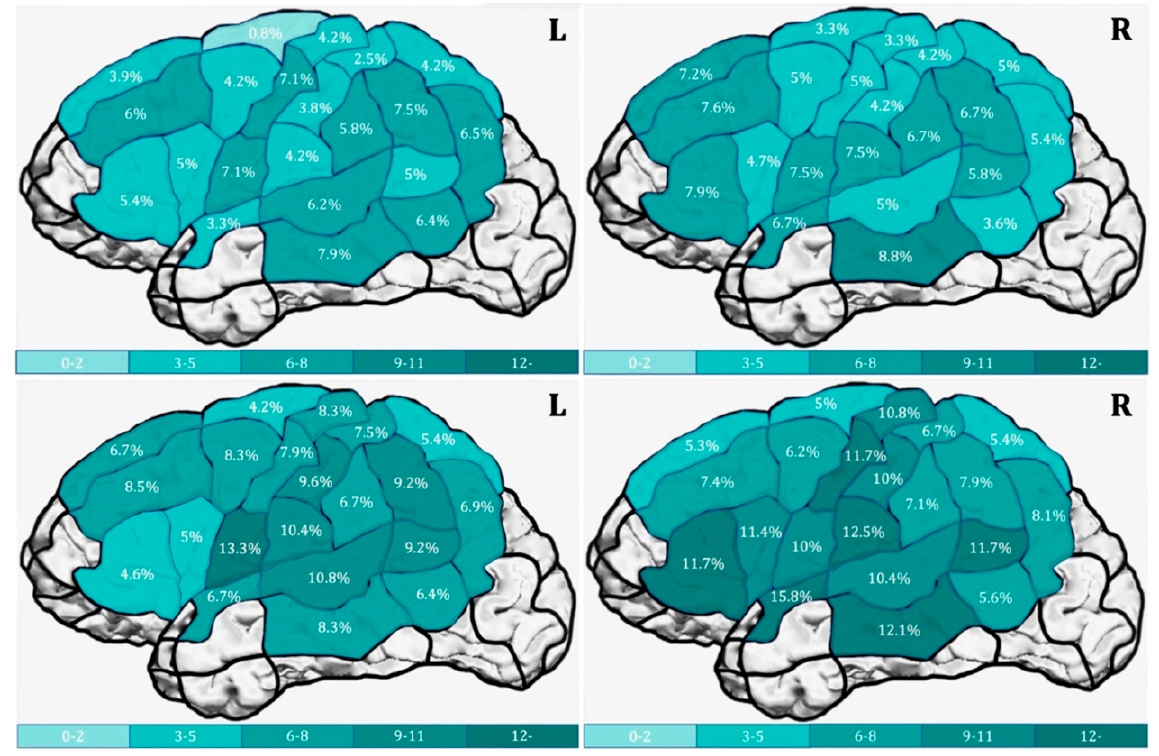
Figure 4. The percentage of errors (as color-coded) after nTMS stimulations, produced by a group of 20 non-brain-damaged young adults on object naming ( upper panel ) and action naming ( lower panel ) part of the VAN-POP [1] (figure from Ohlerth et al. [5]).